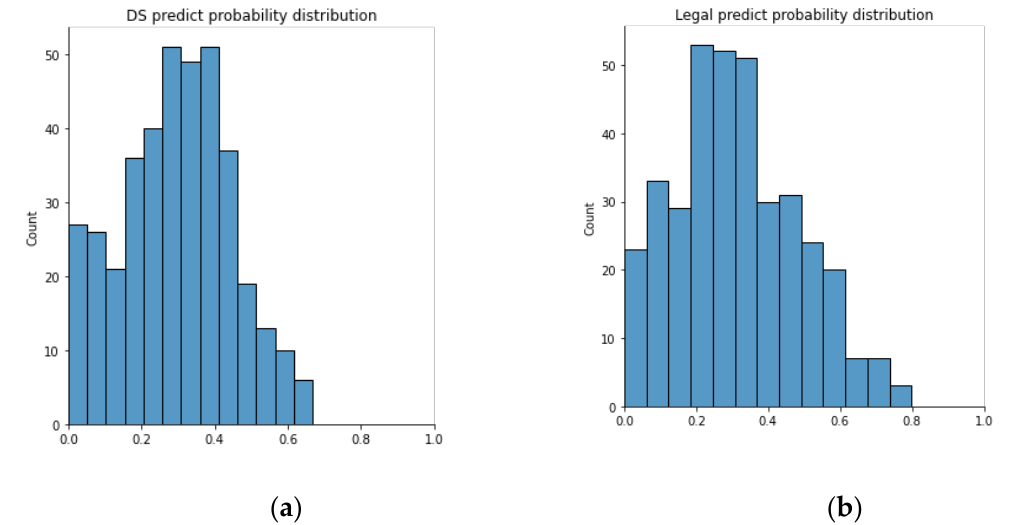
Figure 9. Distribution of: ( a ) predicted DS probability; ( b ) predicted legal probability.